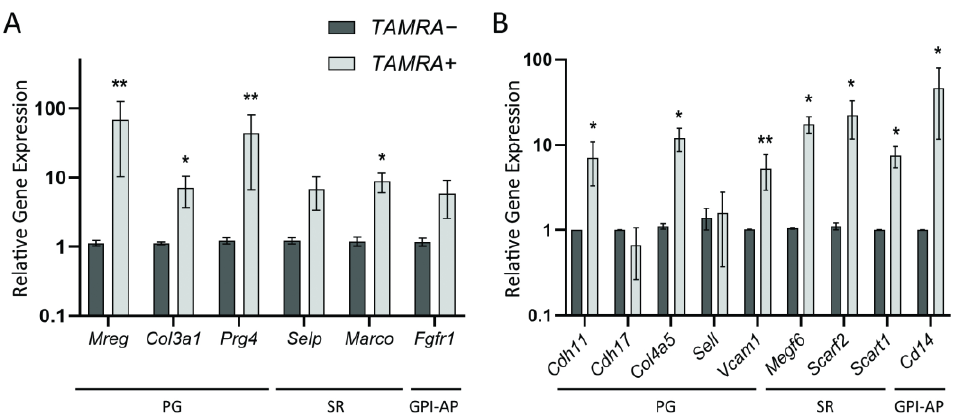
Figure 2. Assessing the relative expression levels for the genes of group-specific factors identified during the transcriptome analysis and presumably involved in dsDNA internalization. ( A ) Real-time PCR with cDNA obtained from Krebs-2 carcinoma. ( B ) Real-time PCR with cDNA obtained from HH47. For each gene, three to five independent PCR rounds were performed in triplicate. Means ± SEM are given, * p < 0.05, ** p < 0.01 (according to the Mann – Whitney U test).